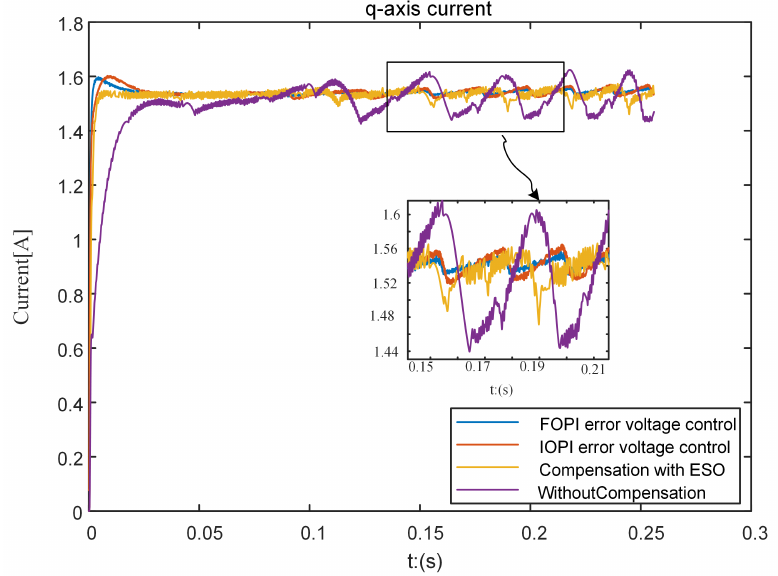
Figure 13. The comparison of I q step current response of three control strategies.